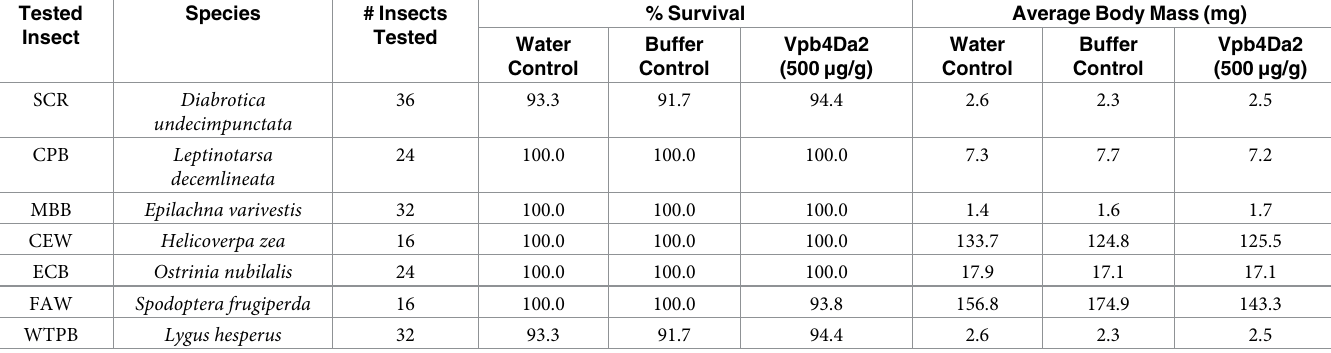
SCR: Southern corn rootworm; CPB: Colorado potato beetle; MBB: Mexican bean beetle; CEW: Corn earworm; ECB: European corn borer; FAW: Fall armyworm; WTPB: Western tarnished plant bug.